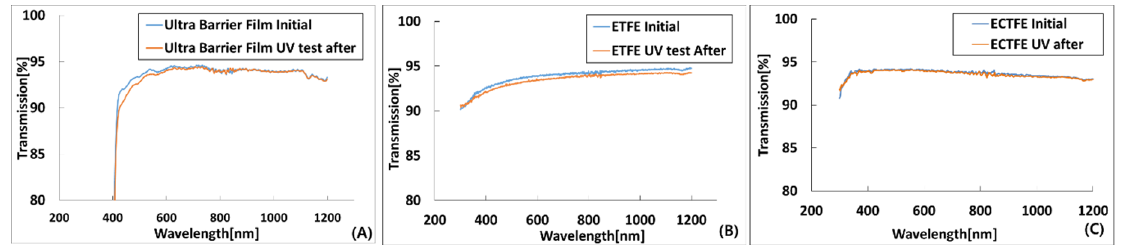
Figure 2. Transmittance of ( A ) ultra-barrier film, ETFE, ECTF before and after the UV test ( B ) Transmittance of ETFE before and after the UV test. ( C ) before and after the UV